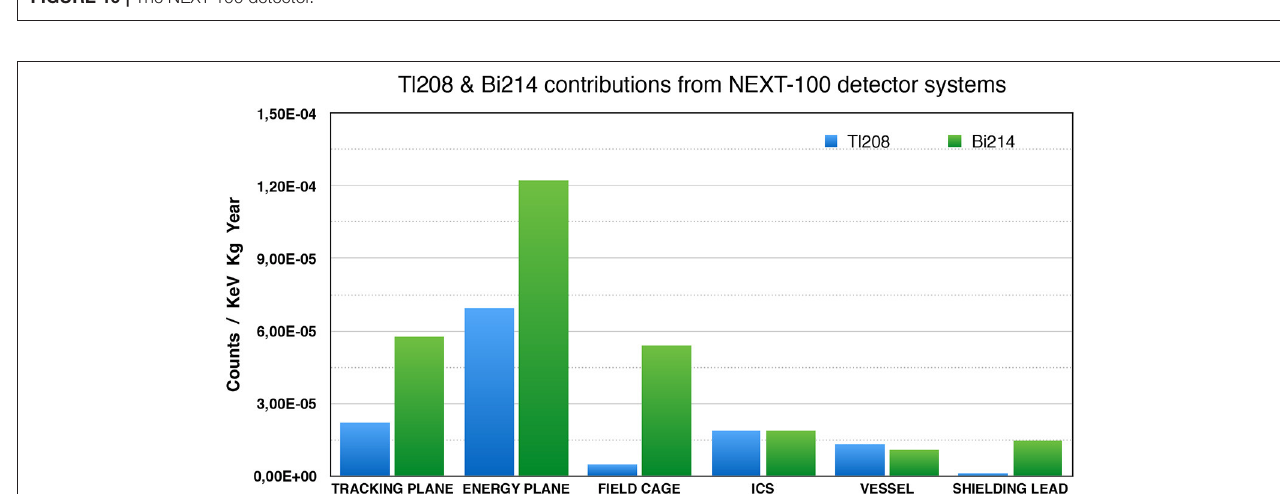
FIGURE 11 | NEXT-100 background budget after selection. Figure from Muñoz Vidal